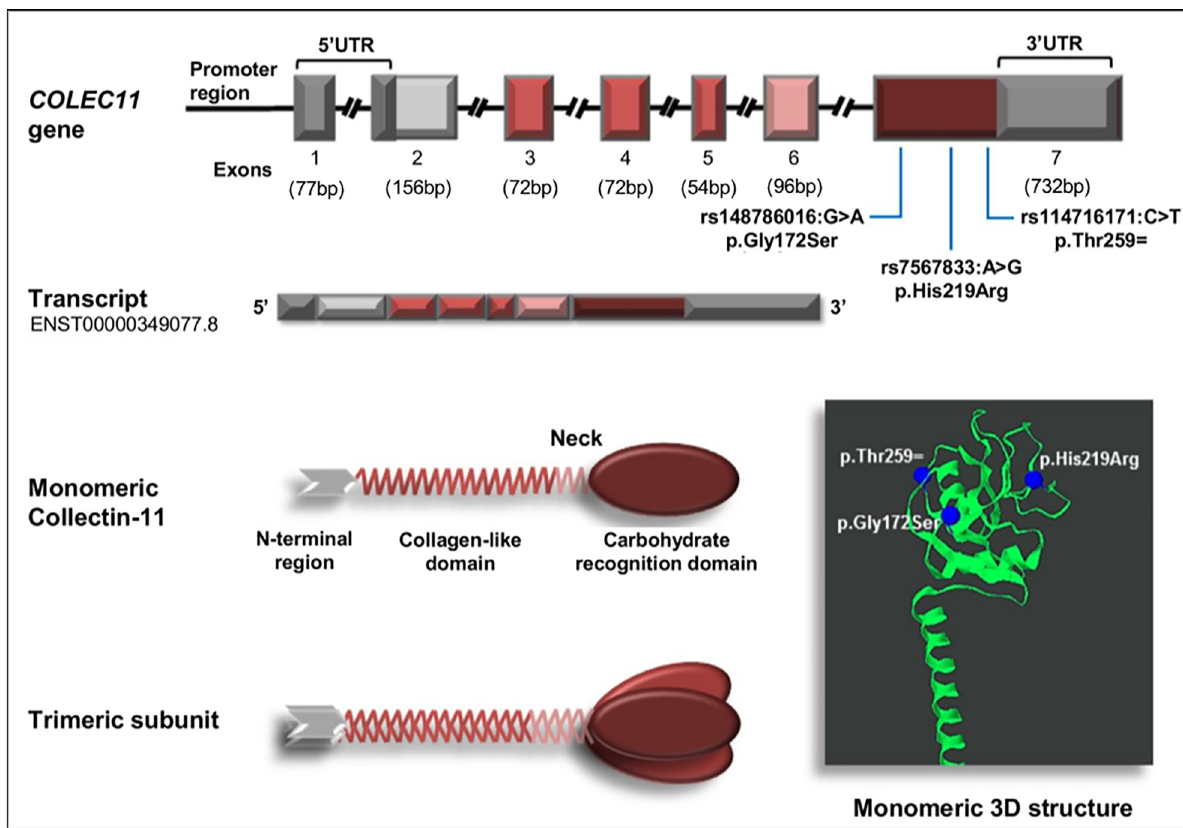
Fig 1. Diagrammatic representation of the COLEC11 locus COLEC11 gene structure based on COLEC11-202 transcript (ENST00000349077.8). Colored boxes represent exons, which encode a specific protein domain. Each collectin-11 monomer comprises an N-terminal region, a collagen-like domain, a linker region and a carbohydrate recognition domain (CRD). Collectin-11 monomers form trimeric subunits that further oligomerize into dimers and trimers of trimeric subunits [21]. The variants evaluated in the present study are indicated in the exon 7 and its position on the CRD domain are shown in the collectin-11 monomeric 3D structure (http://www.mutation3d.org/). Exons are drawn to scale, and introns are